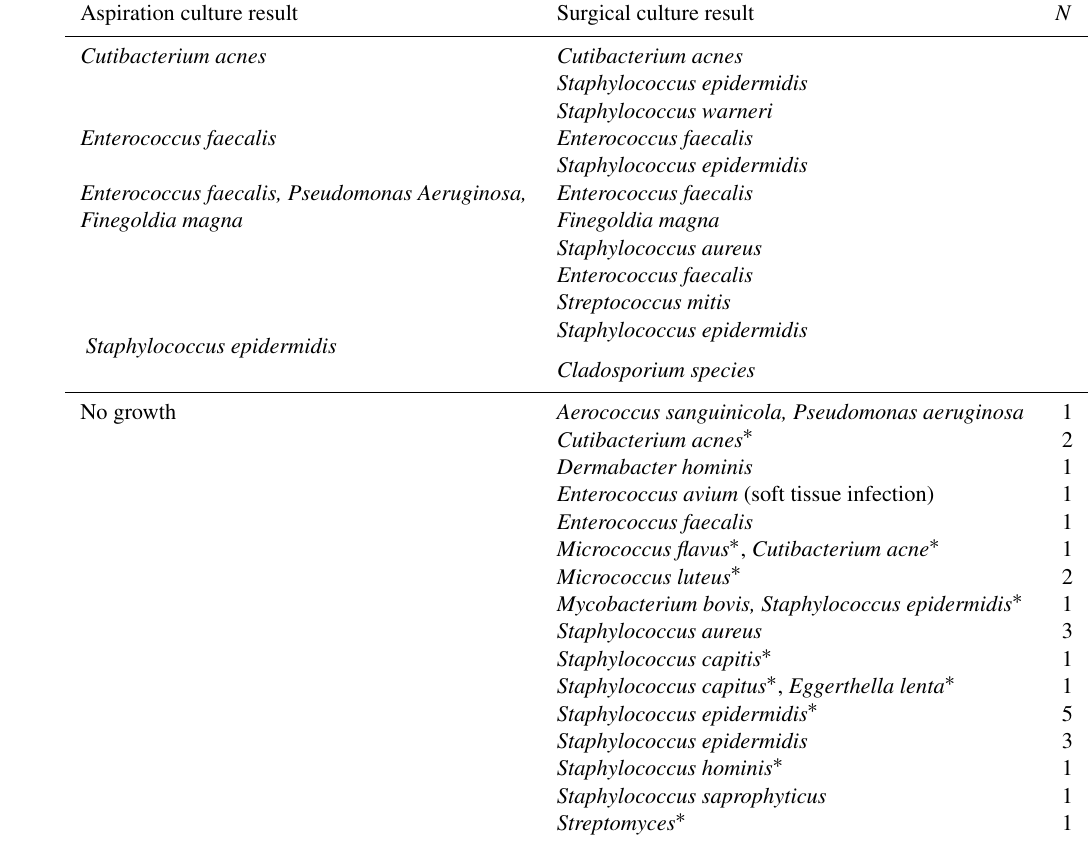
Table 9. Discordant aspiration vs. surgical culture